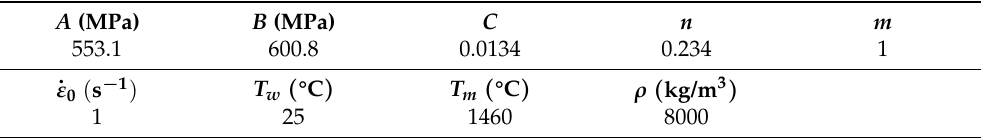
Table 1. Material properties of the AISI 1045 steel